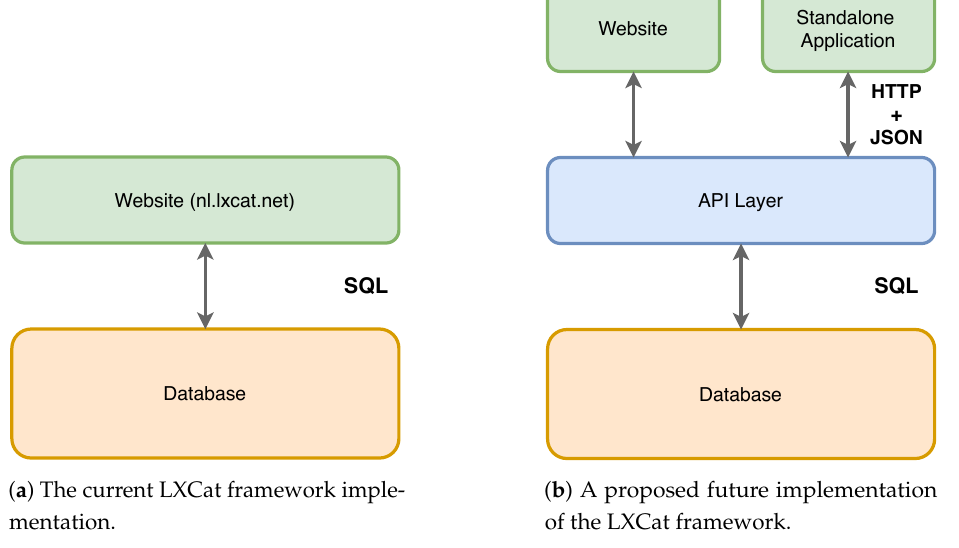
Figure 14. Schematic representation of the current ( a ) and proposed ( b ) framework implementations. Currently, the website is directly coupled to the database. The proposed implementation adds an API layer that can serve multiple frontends through a set of well-defined